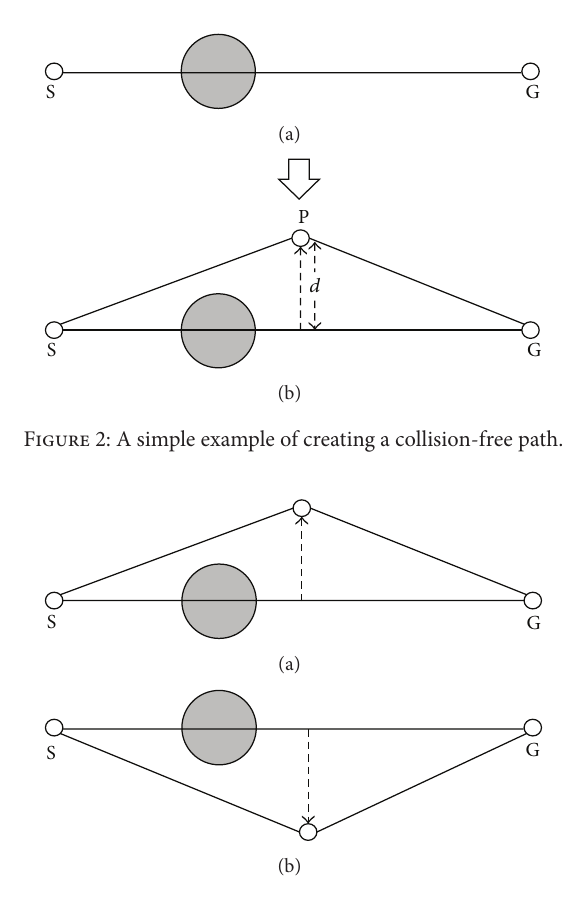
Figure 3: Two directions for a path to create a new turning point.